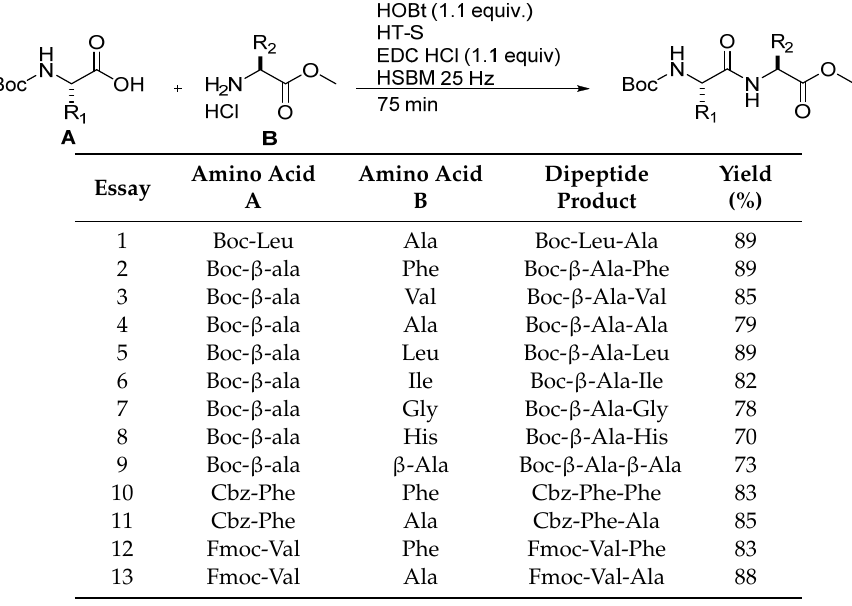
Table 2. Scope of the coupling reaction of amino acids catalyzed by Mg-Al hydrotalcite [75].